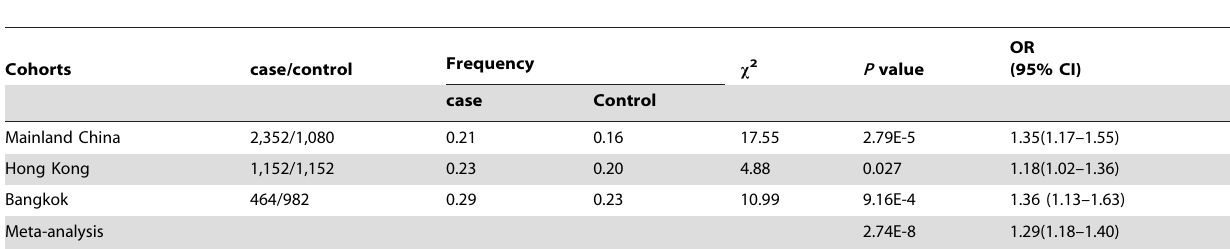
Table 1. Association between the rs57095329 G allele and SLE in independent cohorts and in the combined sample.